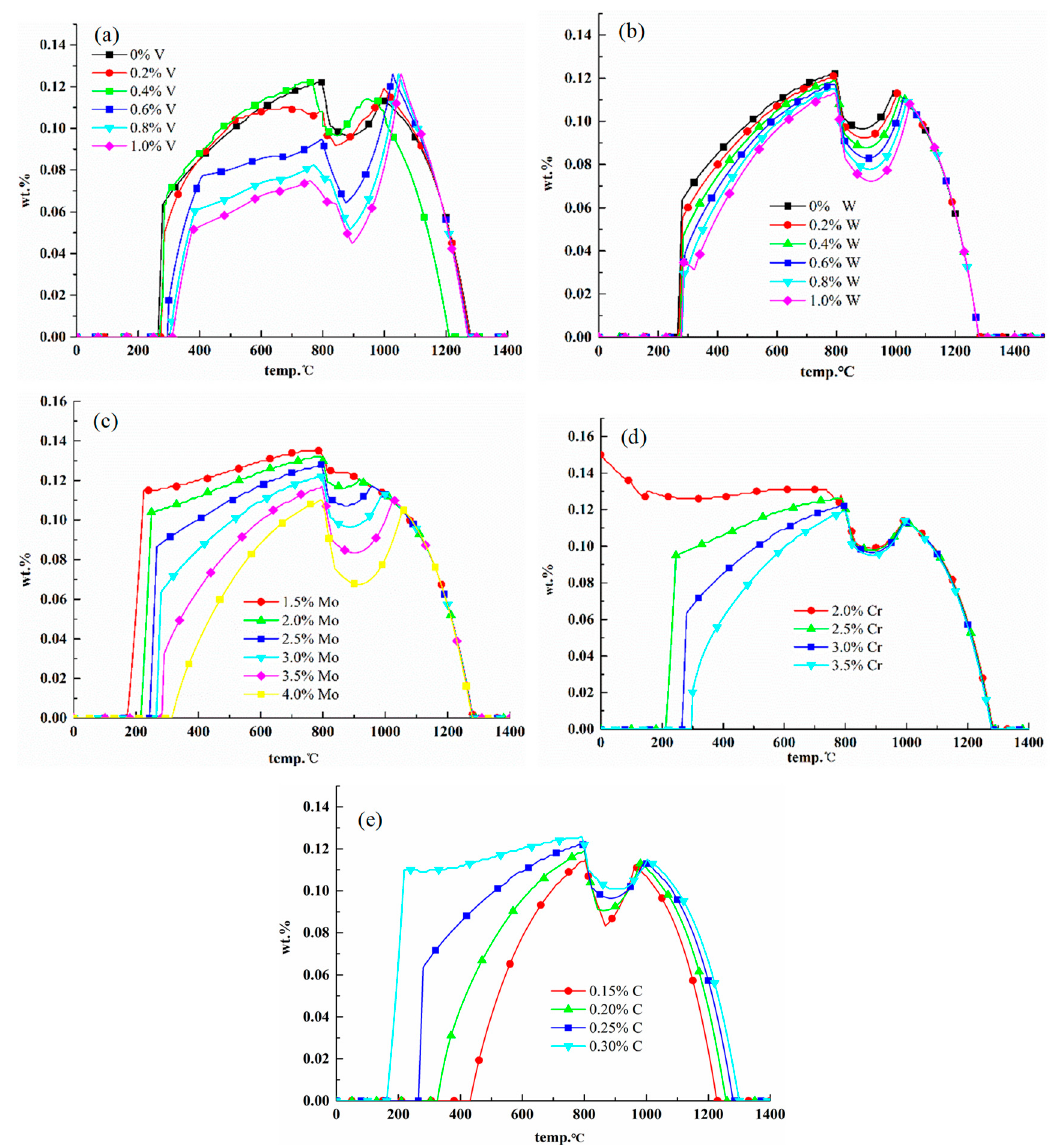
Figure 5. E ff ects of alloying elements on MC carbides. ( a ) E ff ect of V on MC; ( b ) e ff ect of W on MC; ( c ) Figure 5. Effects of alloying elements on MC carbides. ( a ) Effect of V on MC; ( b ) effect of W on MC; e ff ect of Mo on MC; ( d ) e ff ect of Cr on MC; ( e ) e ff ect of C on ( c ) effect of Mo on MC; ( d ) effect of Cr on MC; ( e ) effect of C on MC. There are some differences between the simulated carbides and the actual observations results.